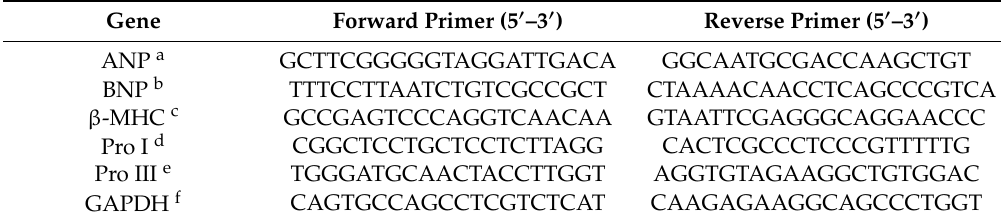
Table 2. Sequences of primers used for real-time polymerase chain